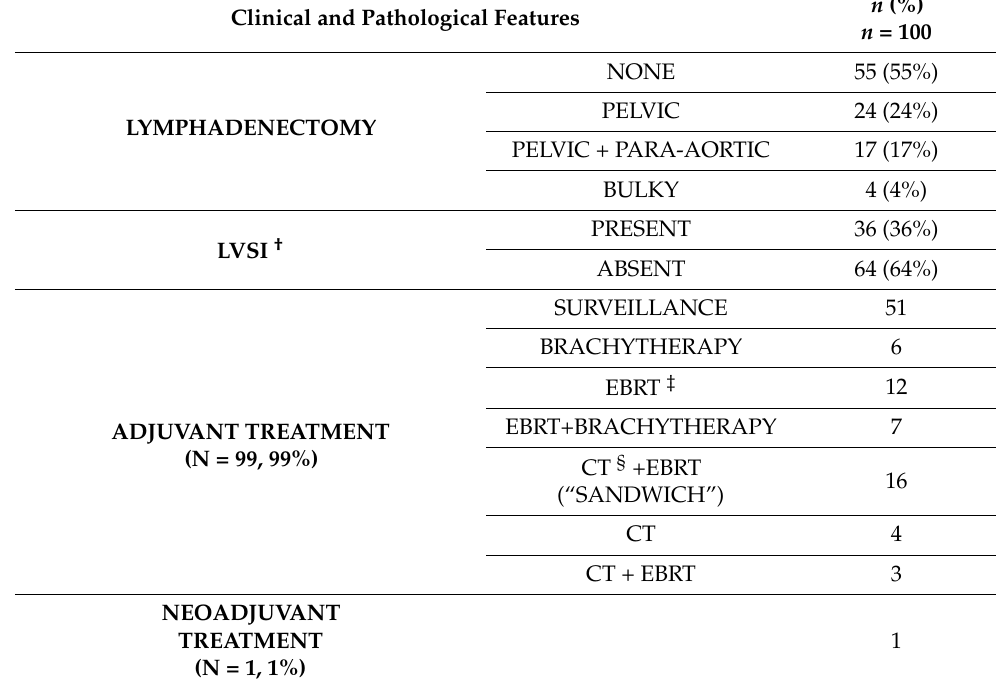
Table 1. Cont. Clinical and Pathological